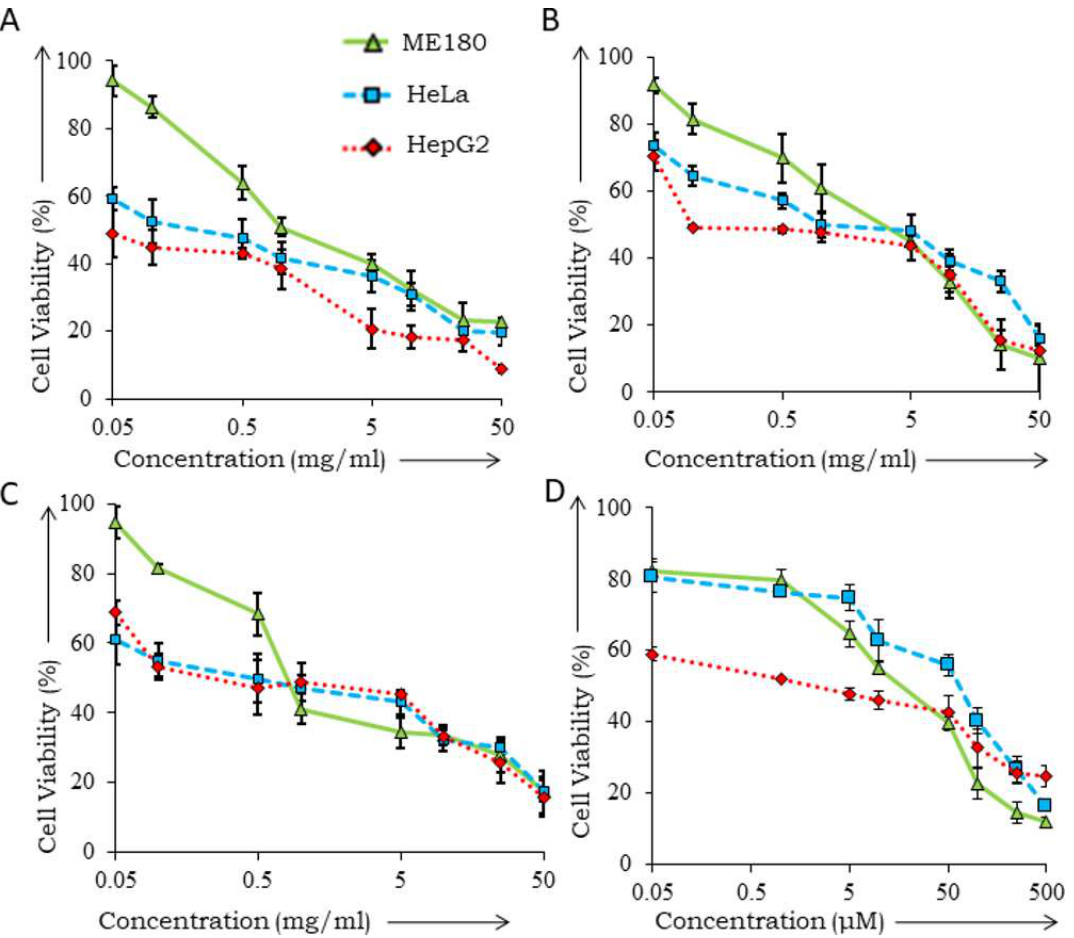
Figure 3. Comparative cell viability assay on three cell lines: HeLa (blue intermittent line with square marker), ME-180 (green continuous line with triangle marker) and HepG2 (red dotted line with diamond marker) using R. cordifolia extracts ( A ) methanol extract, ( B ) ethanol extract, ( C ) aqueous extract and ( D ) 5-Flurouracil. The cell viability is relative to the vehicle control (cells treated with solvent in equivalent amounts of respective extract). Results were expressed as the mean ± SD of three independent experiments. Table 7. IC 50 of R. cordifolia extracts on viability of HeLa, ME-180 and HepG2 cells.